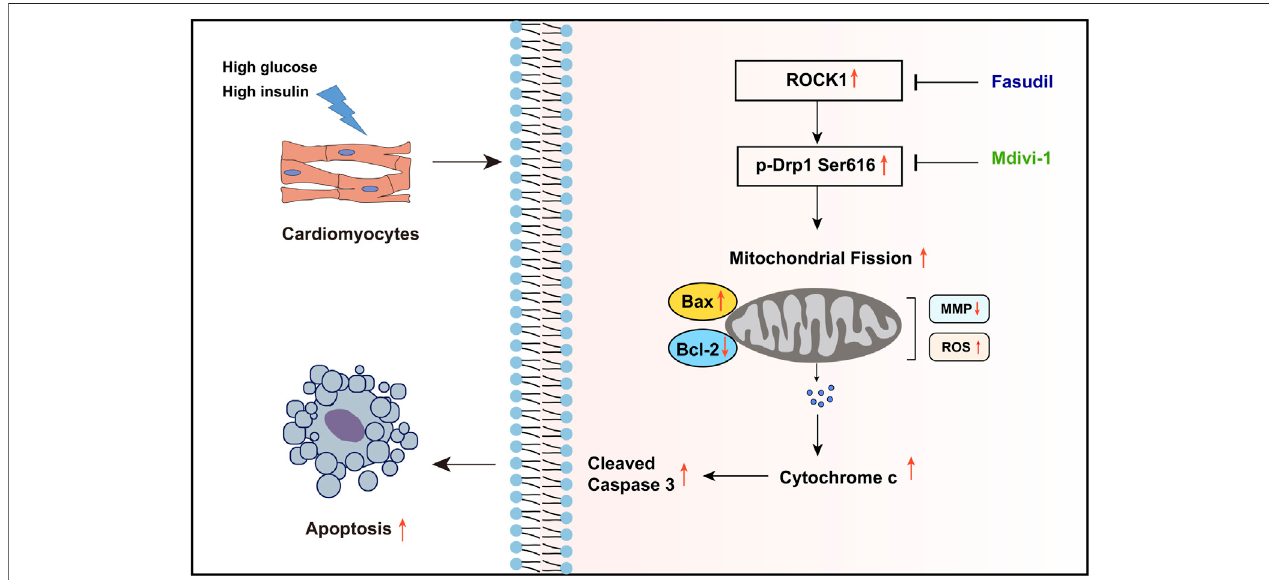
FIGURE 8 | Summary of the mechanisms of Fasudil that inhibit excessive mitochondrial fi ssion in DCM. The high glucose and high insulin environment caused by type 2 diabetes stimulates the expression and activity of ROCK1 in cardiomyocytes, and increases the phosphorylation of its downstream Drp Ser616 site, which leads to excessive mitochondrial fi ssion and ultimately increases cardiomyocyte apoptosis. Fasudil can inhibit the expression and activity of ROCK1, thereby reducing cardiomyocyte apoptosis.